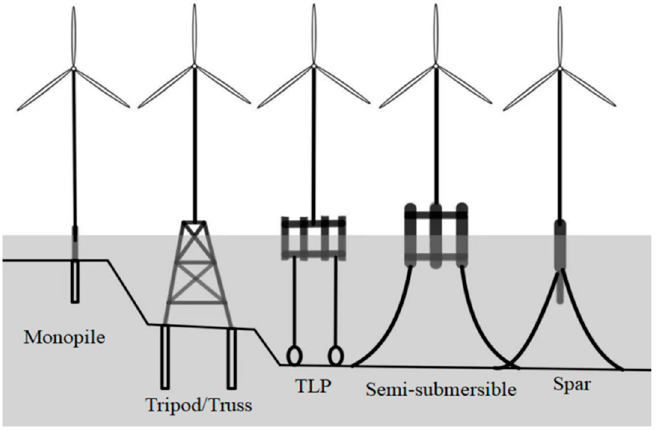
Figure 1. Types of offshore wind turbines.